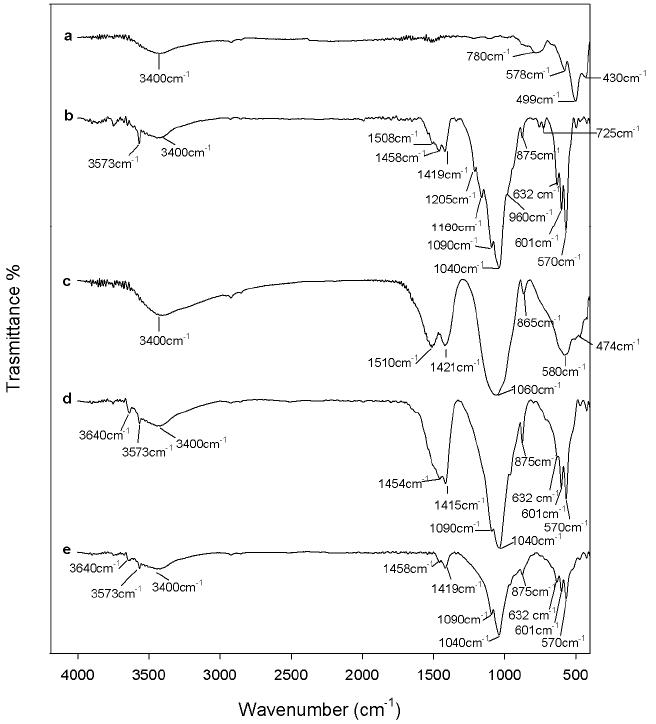
Figure 2. FTIR of ( a ) ZrO 2 ; ( b ) Hap; ( c ) 9ZrO 2 · 1Hap; ( d ) 7ZrO 2 · 3Hap; and ( e ) 5ZrO 2 · 5HAp gels, heated to 600 °C.